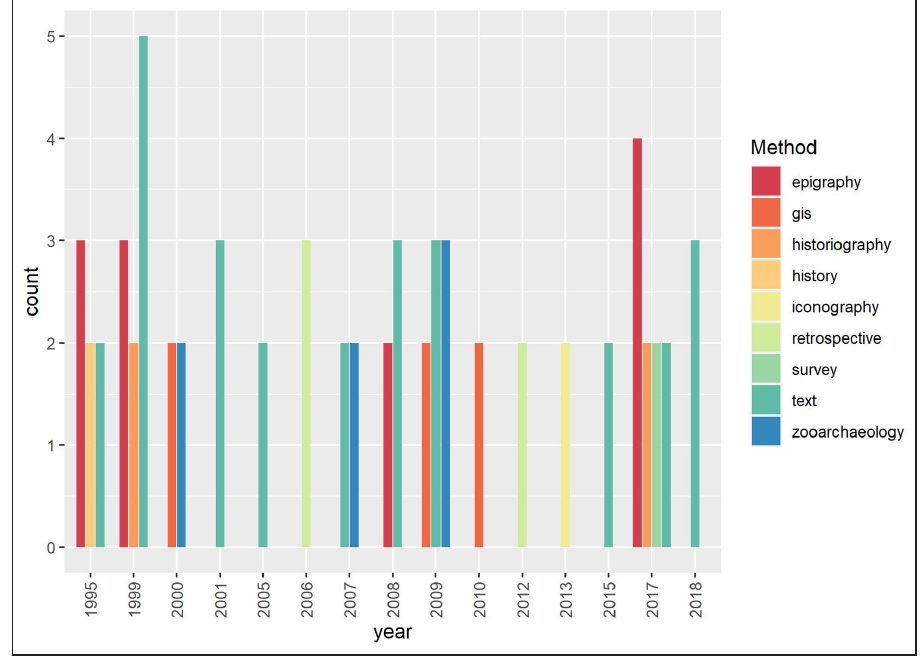
Figure 7: Frequency of ‘method’ key words used in publications per year (all terms used more than twice per year are